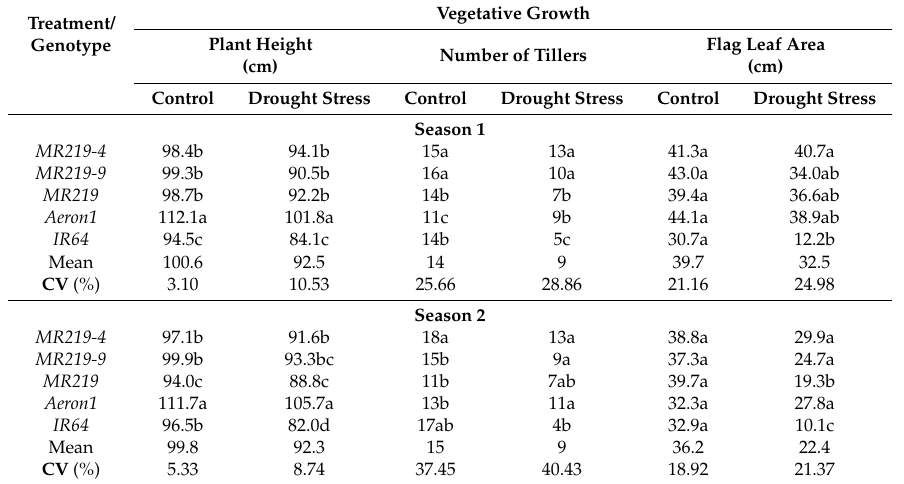
Table 2. Plant growth traits in rice genotypes as affected by drought stress treatment at different seasons.